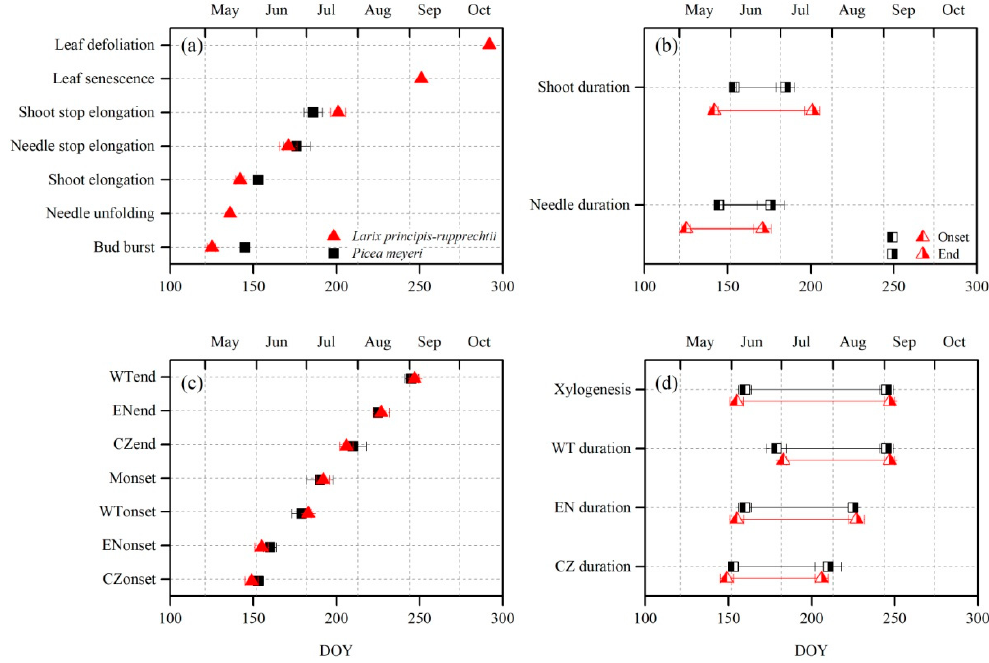
Figure 5. Dates of occurrence of primary ( a , b ) and secondary growth ( c , d ) for spruce and larch. (CZ: cambial zone, EN: enlargement cell, WT: wall thickening cell, M: mature cell). Error bars indicate the standard deviation between trees.